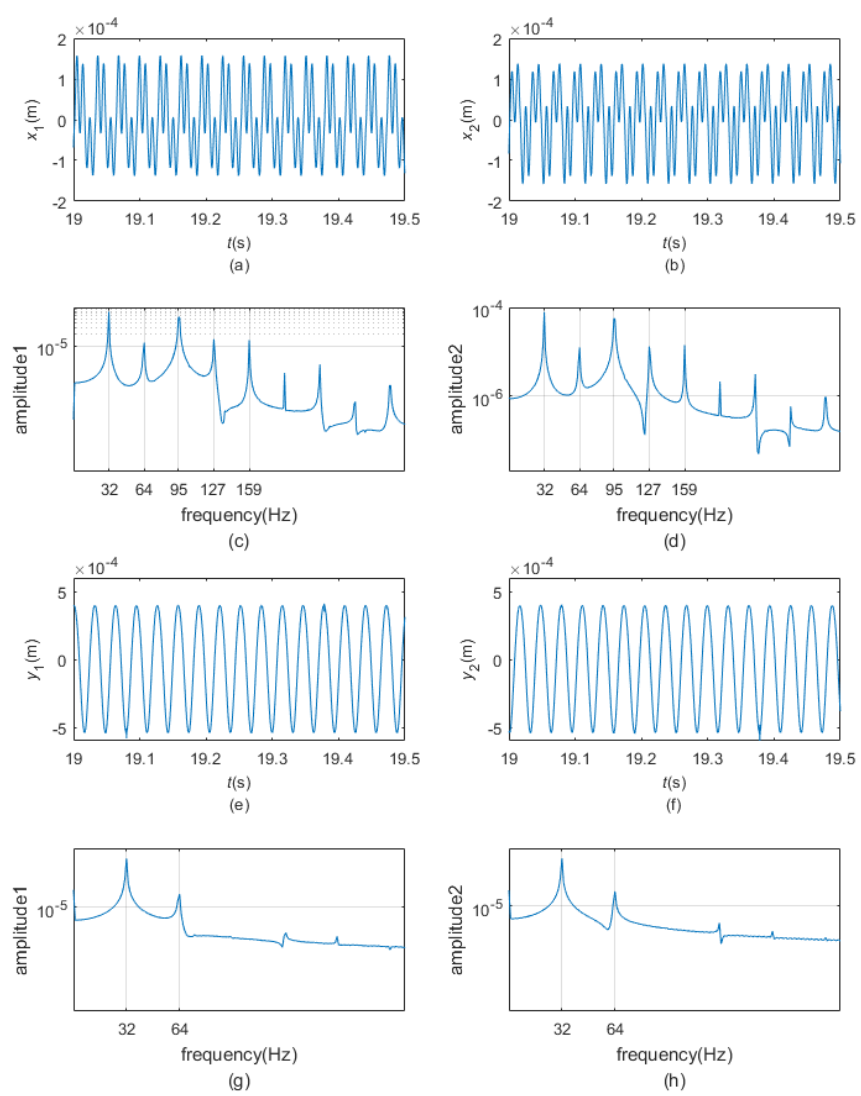
Figure 10. The motion and frequency spectrums of the dampers in the x direction ( a, b, c, d ); the motion and frequency spectrums of the dampers in the y direction ( e, f, g, h ).